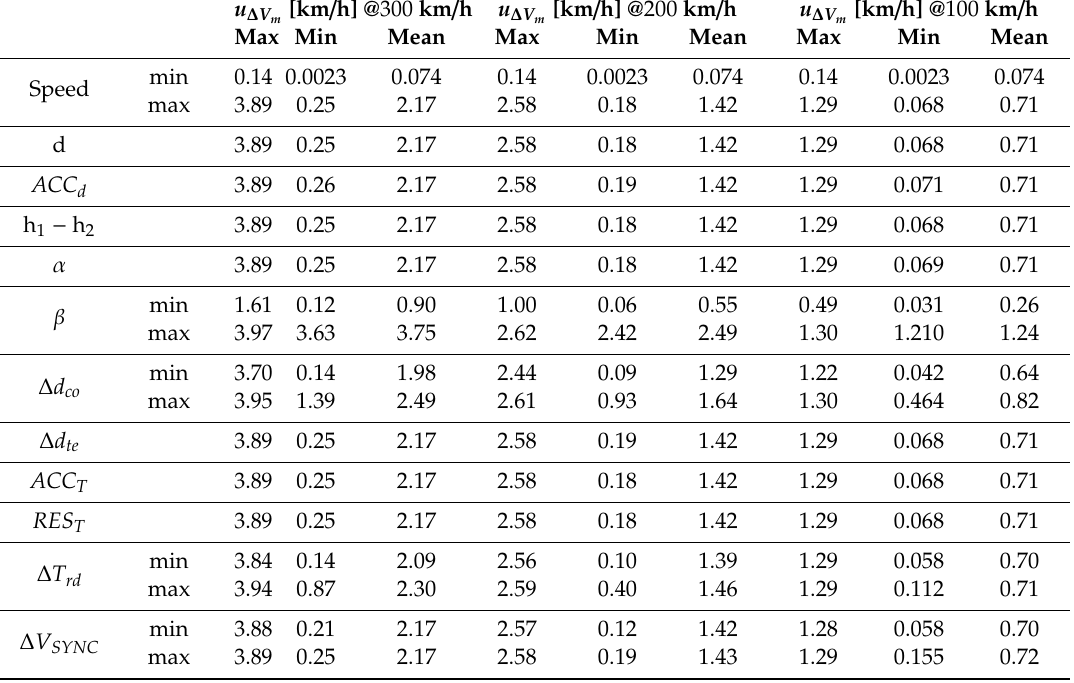
Table 5. Summary results for the case study 5 considering 1000 random repetitions (for all parameters except d that is fixed to 5 m): Maximum (max), minimum (min), and mean (mean) of the obtained uncertainties u ∆ V versus the di ff erent uncertainty m